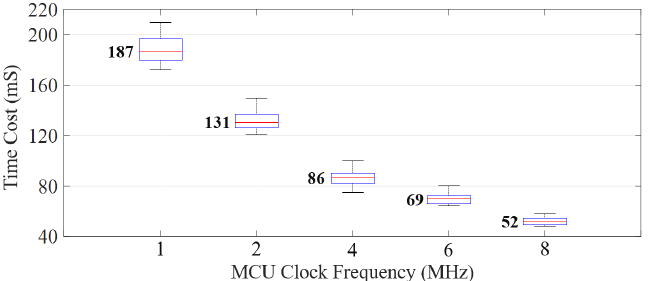
Figure 13. The time cost to identify a user under different clock frequency of the microcon- troller